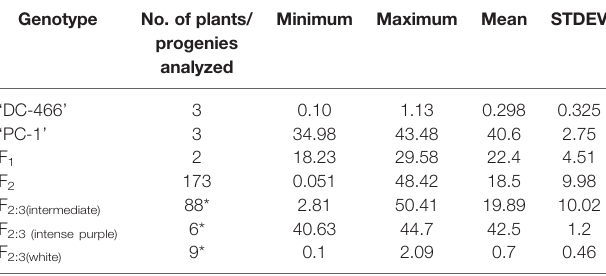
TABLE 3 | Anthocyanin content (mg/100 g FW) in parents, F 1 , F 2 , and F 2:3 of ‘ DC-466 ’ × ‘ PC-1 ’ combination. Genotype No. of plants/